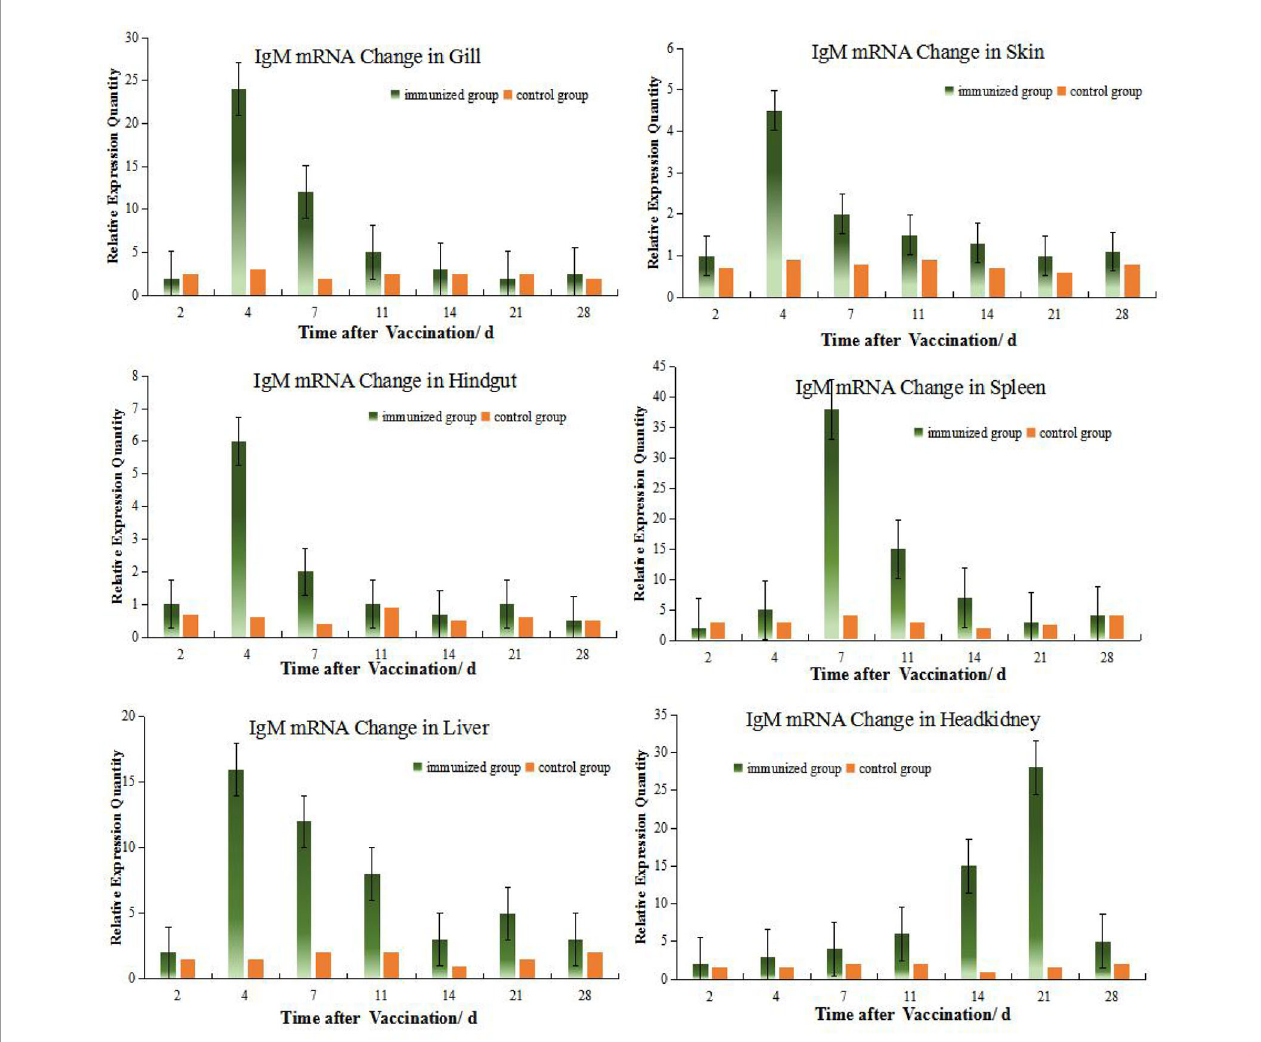
FIGURE 2 | Relative quanti fi cation of crucian carp IgM gene mRNA in different organs. The relative abundance for IgM mRNA from the tissues was ranked as spleen > HK> gill >liver > hindgut>skin. The alterations in mRNA levels over time were similar for the gills, skin, hindgut and liver with increases at day 4 post-inoculation. And there were clear change difference between spleen and HK at this experiment, although both organs are central immune